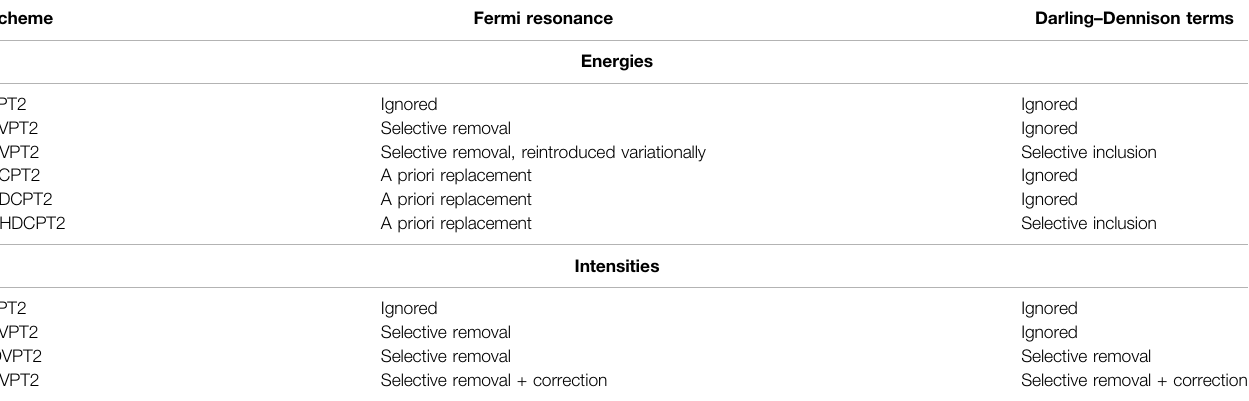
TABLE 2 | Summary of the available VPT2 schemes to compute vibrational energies and intensities, and the strategies applied todeal with Fermi resonances and to include Darling – Dennison interaction terms. See text for details. Scheme Fermi